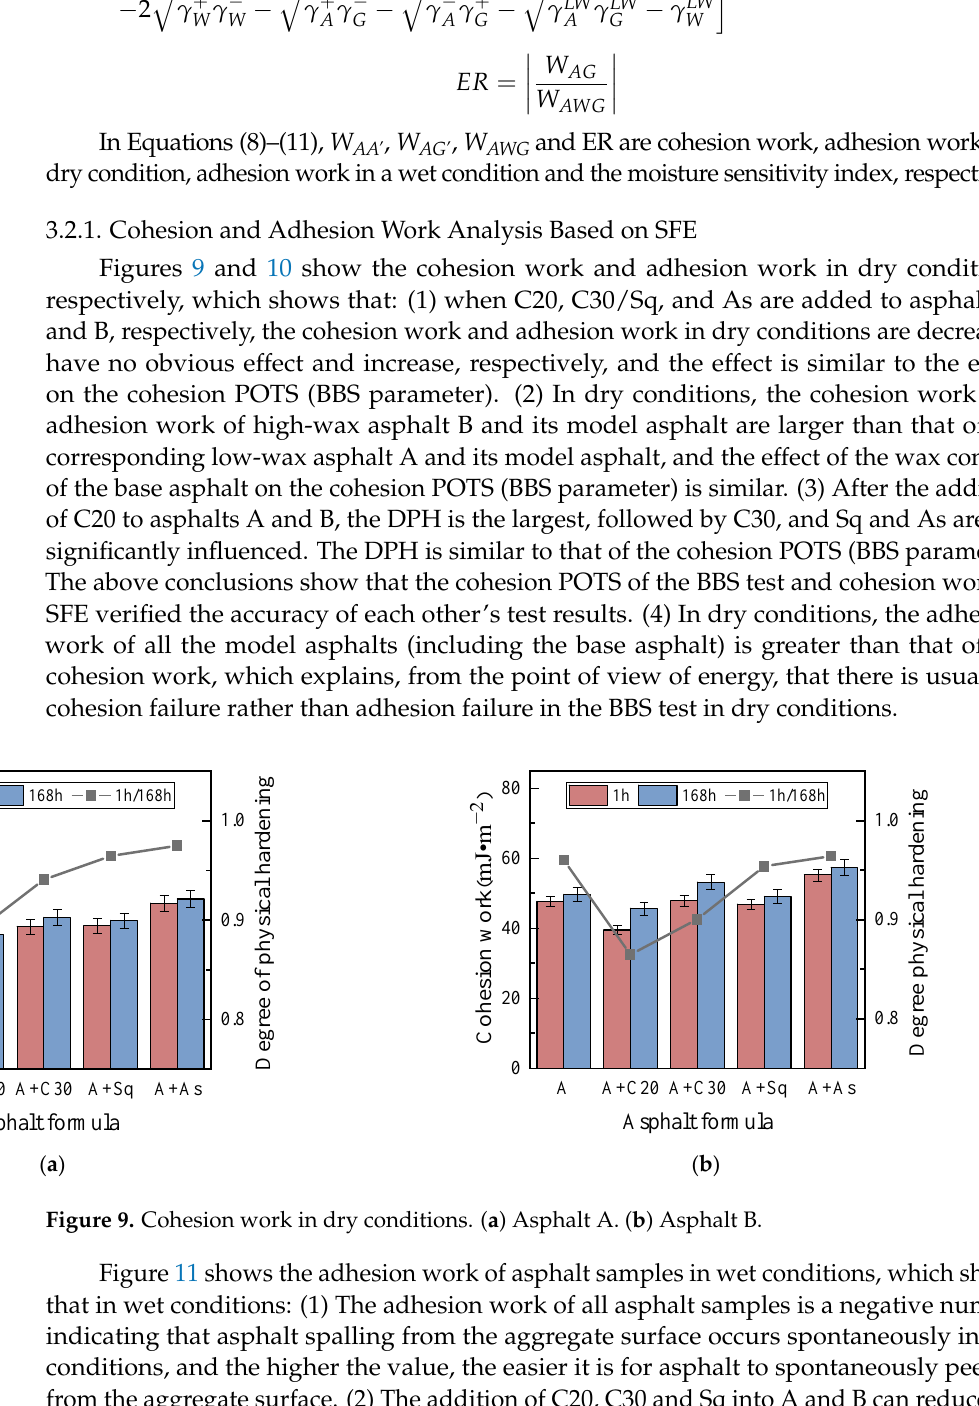
Figure 10. Adhesion work in dry conditions. ( a ) Asphalt A. ( b ) Asphalt B.